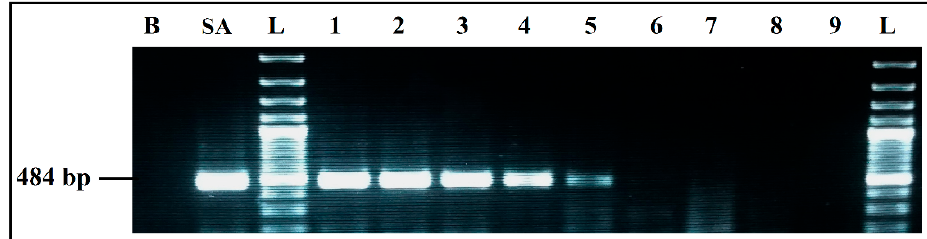
Figure 3. Detection sensitivity of S. aureus primers Nuc 484 bp, in simplex PCR. B, negative control; SA, positive control S. aureus 435 CECT; L, 100 bp DNA ladder; lane 1 to 6, PCR results from 2457 pg/ μ L to 0.03 pg/ μ L DNA; lane 7 to 9, PCR results from 0.003 pg/ μ L to 0.00003 pg/ μ L DNA; L, 100 bp DNA ladder.